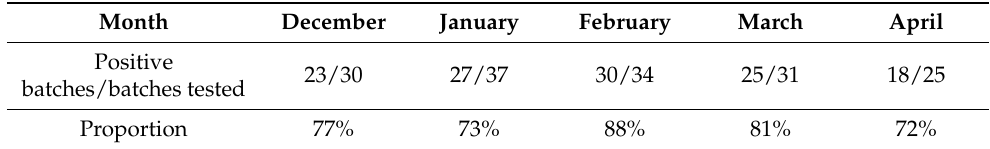
Table 4. Monthly detection rates by RT-PCR for at least one virus in batches of Heliococcus bohemicus L2 nymphs during their overwintering under vine bark (number of positive nymph batches/number of batches